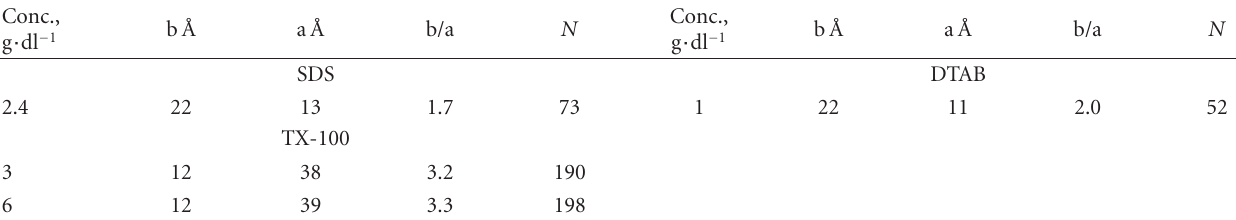
Table 3: Micellar parameters for prolate ellipsoids of surfactant solutions in D 2 O at 30 ◦ C.